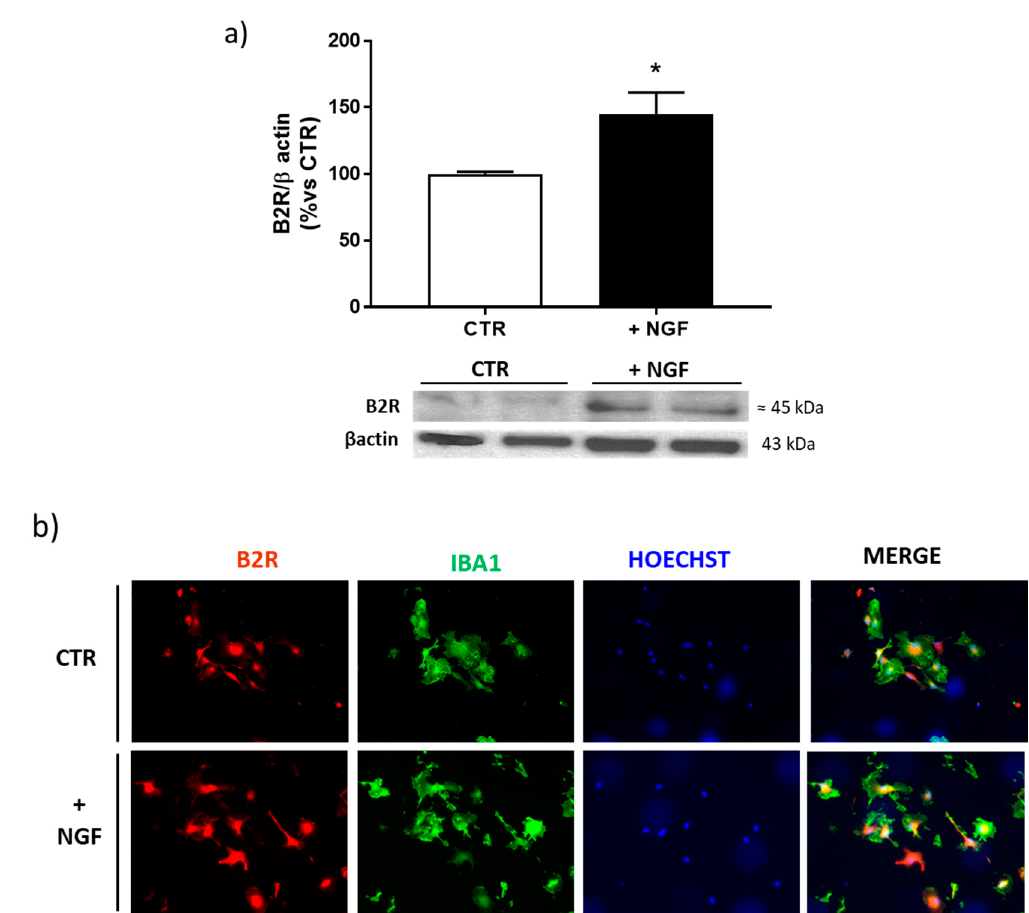
Figure 4. Expression of bradykinin receptor 2 (B2R) after NGF treatment in cortical microglial cells. ( a ) Western blot analysis of B2R protein expression in enriched microglial cells cultures treated for 48 h with NGF 100 ng/mL (+NGF), normalized against β -actin, and expressed as a percentage of the control (CTR). Data represent means (±S.E.M.) from four independent experiments run in duplicate. Statistically significant differences were calculated by one-way analysis of variance (ANOVA) followed by Bonferroni’s test for multiple comparisons (* p < 0.05). ( b ) Representative immunofluorescence images of microglial cells stained with antibodies for B2R (red) or microglia (Iba1, green) and nuclei (Hoechts, blue) in control conditions (CTR) and after NGF treatment (+NGF). Scale bar: 15 μ m.